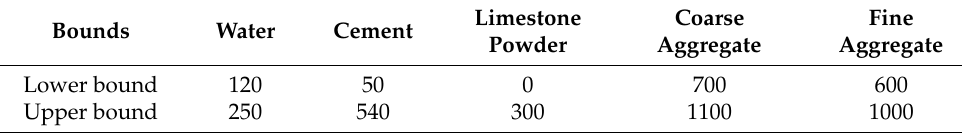
Table 2. Restraint of constituent contents (kg/m 3 ).